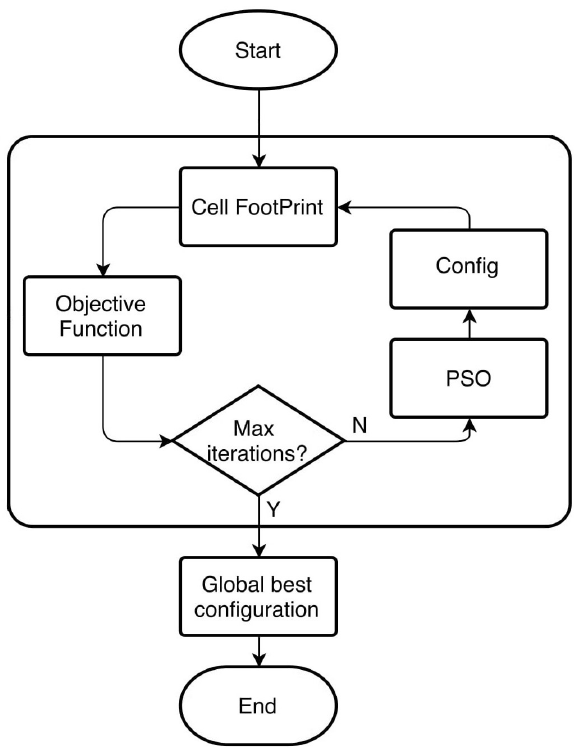
Figure 3. Flowchart for the antenna tilt and handover optimization